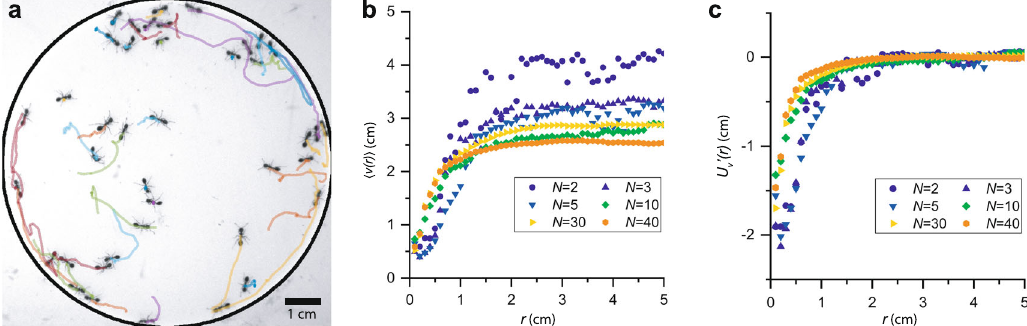
Fig. 1 | Motility-induced attraction between ants. a Forty fi re ants con fi ned in a 2D cell with their tracked trajectories over the previous 3s shown as colored lines. The edgeof the cellisoutlinedinblack forclarity. b Averagespeedof the ants asa